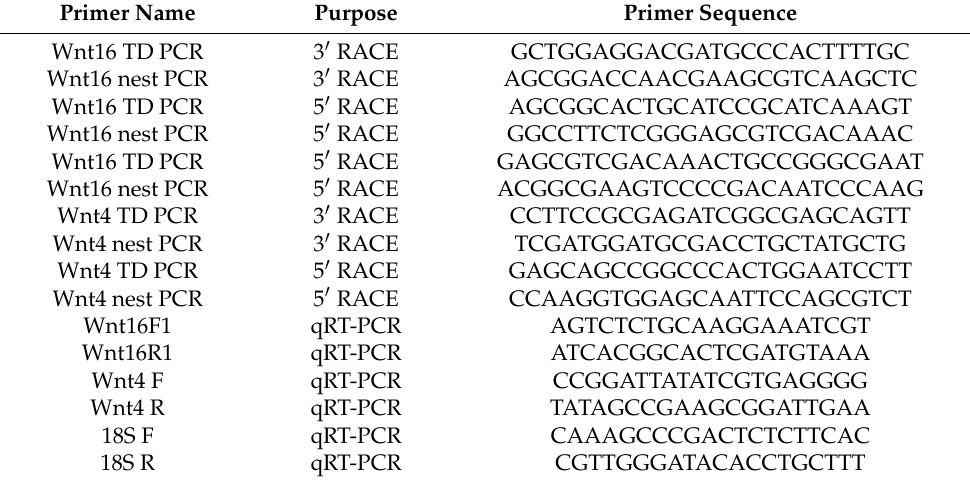
Table 1. Primers used in cloning and characterising the gene of DpWnt4 and